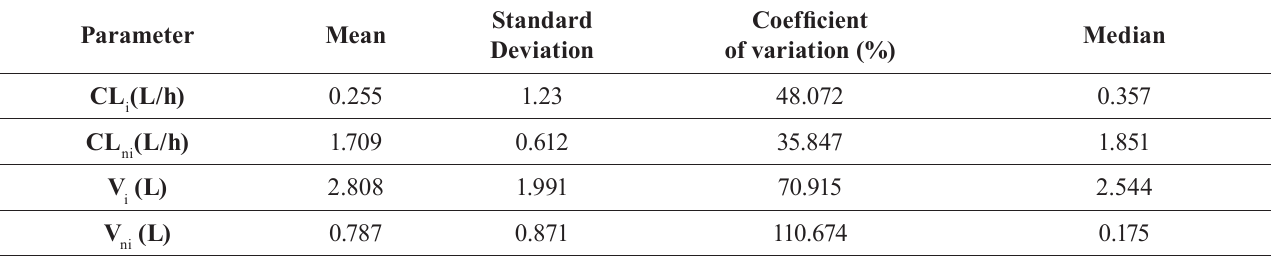
TABLE II - PK population Parameter estimates for vancomycin